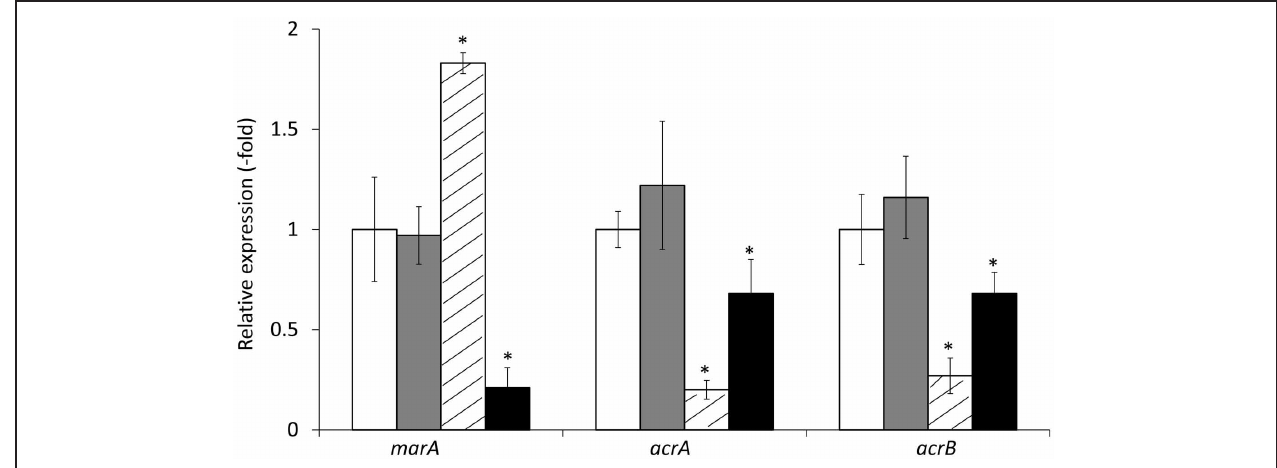
transformed wild-type of acrR ); black, HUE1-wt- marR (HUE1 strain transformed wild-type marR ). ∗ p < 0 . 05 compared to HUE1. Data represent the mean ± standard deviation values calculated from at least three independent experiments.